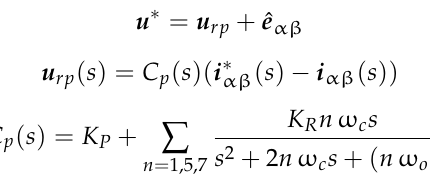
Figure 4. Experimental test setup. Table 1. Specifications of a grid connected inverter. Parameters